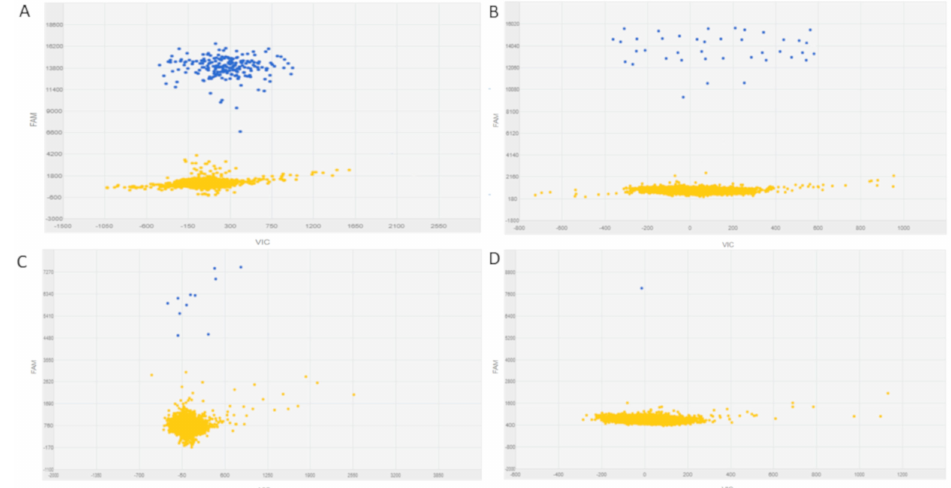
Figure 2. Examples of dilutions of BCR-ABL1 transcript detected by QuantStudio three-dimensional (3D) digital PCR platform. Blue dots represent the micro-reactions positive for BCR-ABL1. Yellow dots represent the micro-reaction negative for the presence of BCR-ABL1. ( A ) Detection of 200 copies of BCR-ABL1 transcript. ( B ) Detection of 50 copies of BCR-ABL1 transcript. ( C ) Detection of 10 copies of BCR-ABL1 transcript. ( D ) Detection of one copy of BCR-ABL1